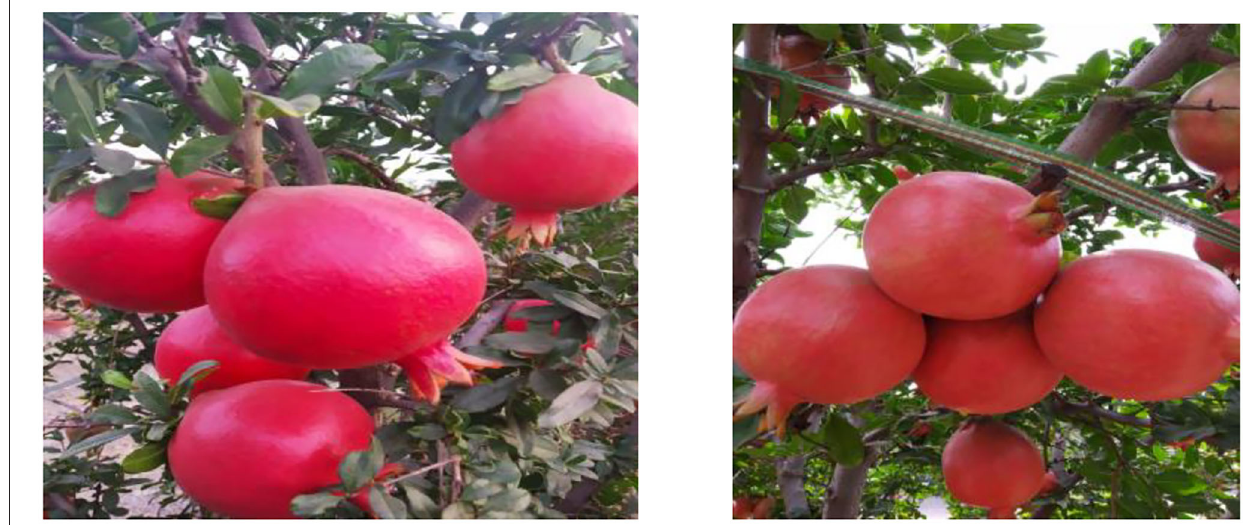
FIGURE 10 | Effect of humic acid preparation on growth of pomegranates.